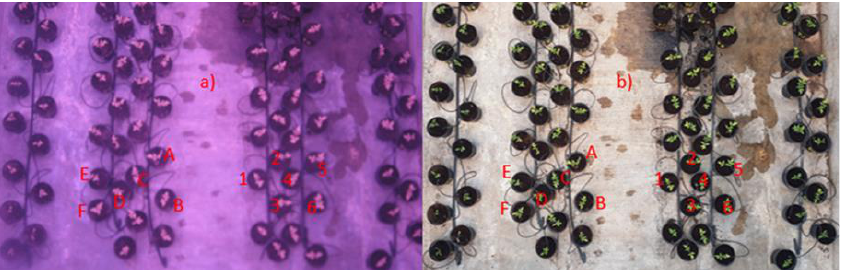
Figure 4. Example of acquired images with both cameras aimed at the same objective. ( a ) NGB camera image. ( b ) RGB camera image. Simbology: plants A to F were not inoculated with B. c -A, and plants 1 to 6 were inoculated with B. c -A.